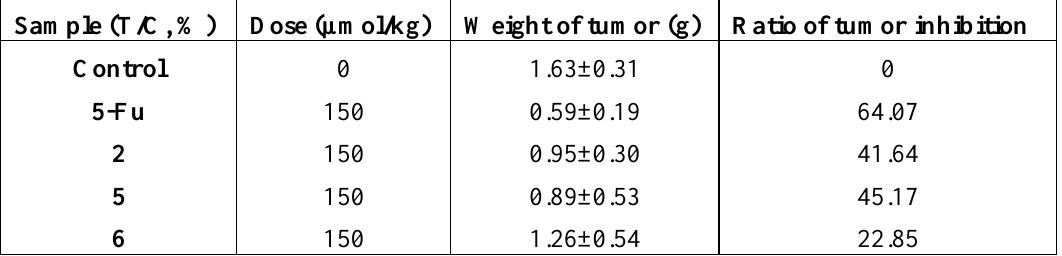
liver cancer. 22